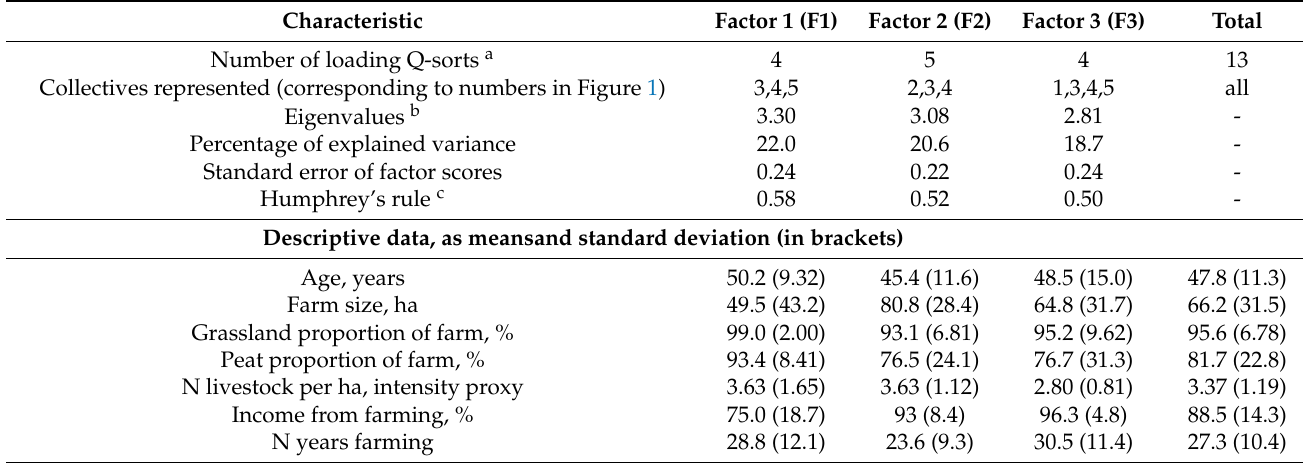
Table 1. Characteristics of rotated and extracted